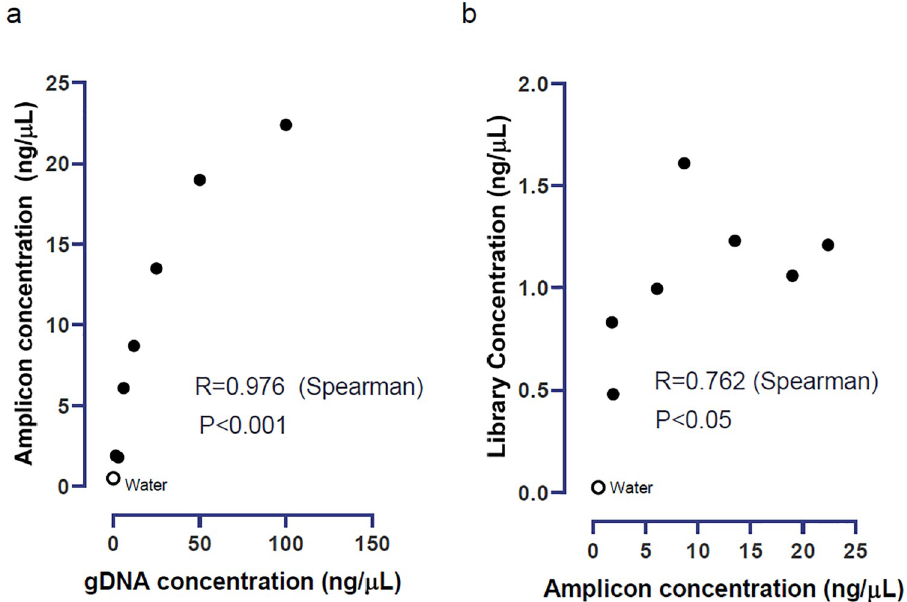
Fig 3. Concentrations of genomic DNA (gDNA), amplicons, and libraries in the titration study. a) Correlation between the gDNA concentrations and amplicon concentrations. b) Correlation between the amplicon concentrations and library